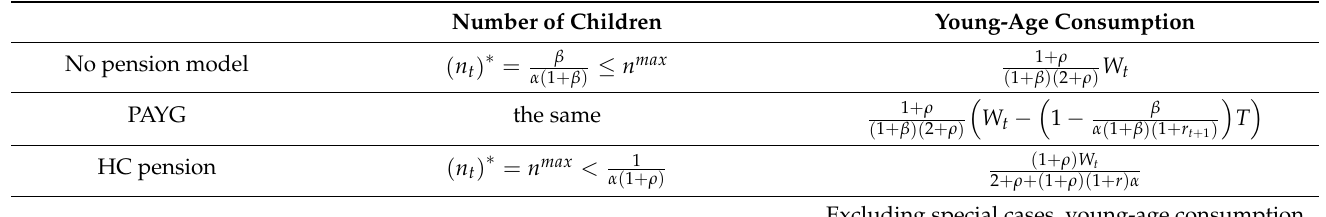
Table A2. Comparison of the Three Instances. Number of Children Young-Age